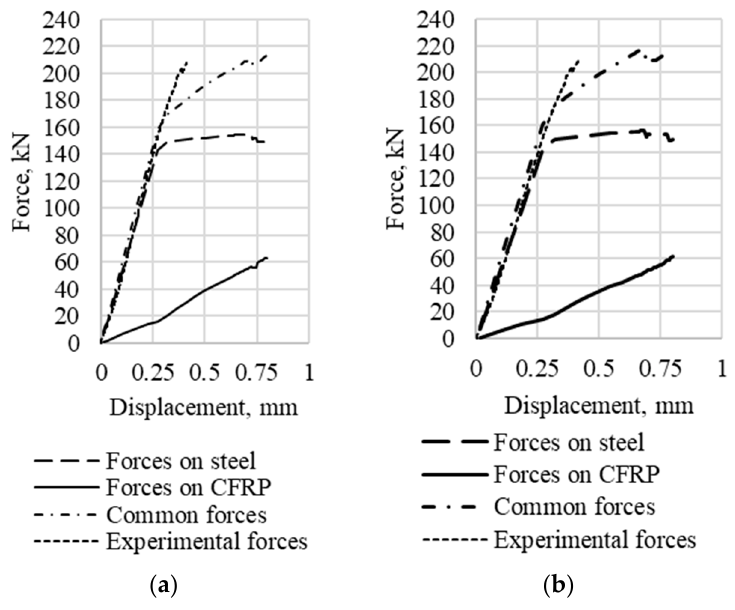
Figure 13. Displacement-force dependencies for a strengthened tensile specimen: ( a ) an adhesive joint model that has one row of finite elements; ( b ) an adhesive joint model that has two rows of finite elements.